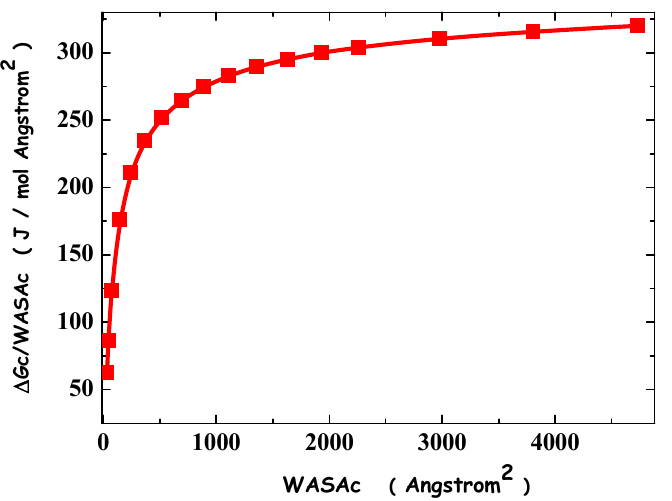
Figure 3. Trend of ∆ G c /WASA c versus WASA c at 298 K, obtained by calculating the ∆ G c values for spherical cavities of increasing radius in water, by means of classic SPT relationships. The experimental density of water at 298 K, and an effective radius of 1.4 Å for water molecules have been used in performing classic SPT calculations.